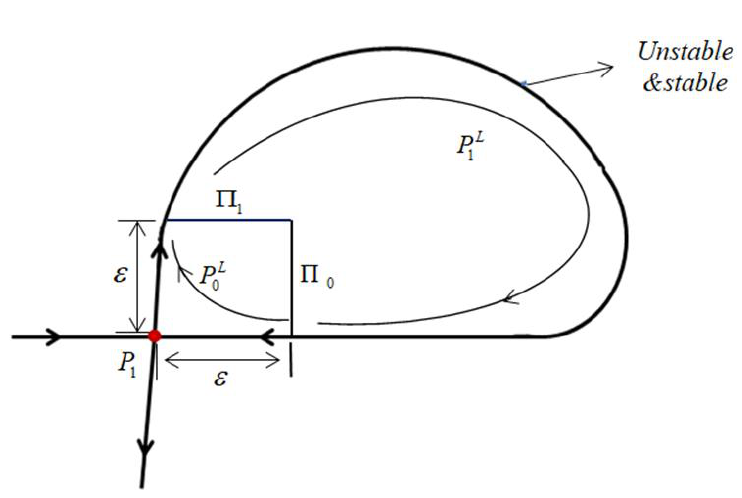
Figure 4. When I = 0, the plane Π 0 and Π 1 under the two-dimensional Poincare  Figure 4. When 0 I = , the plane 0 and 1  under the two-dimensional Poincare map. L P   Define a map from plane 1 to 0 . Since the map from plane 1 1 U    in 1 satisfied the equation 1 1